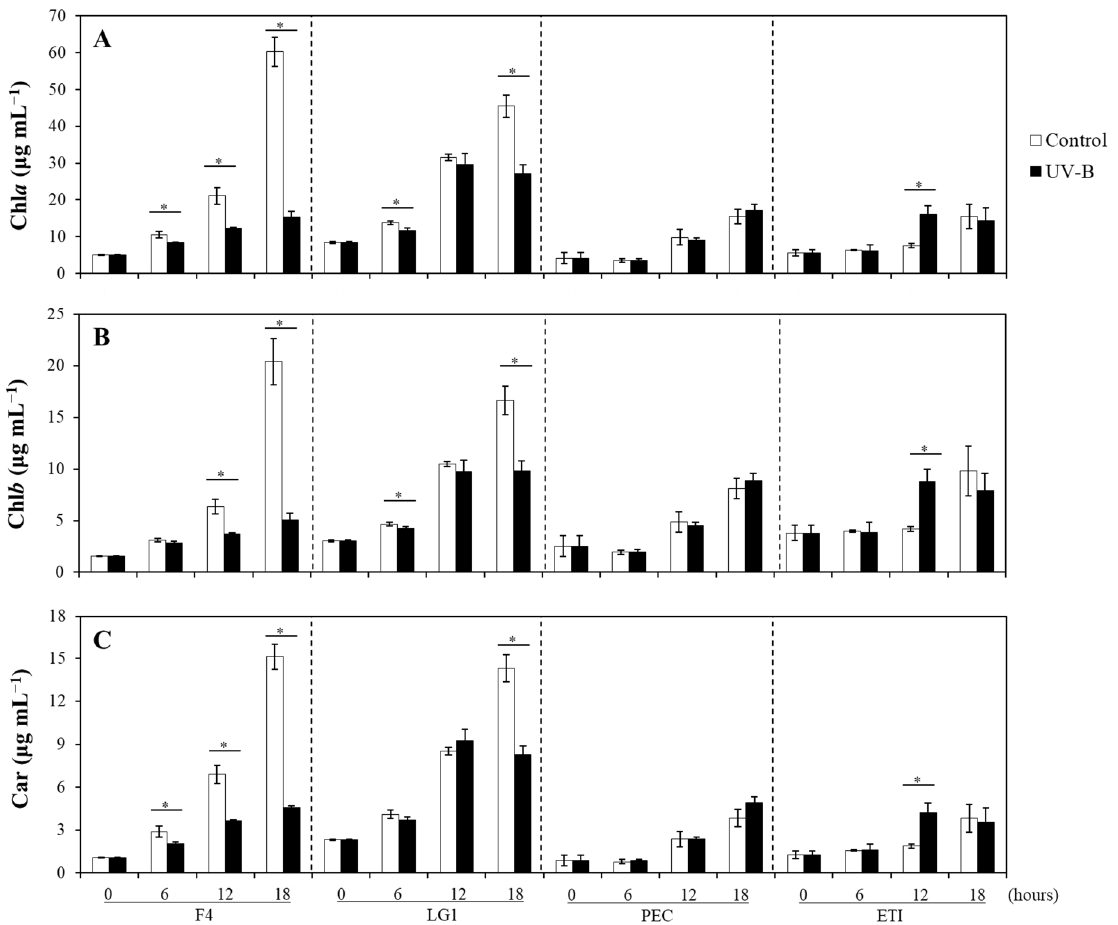
Figure 1. Effects of UV-B on the photosynthetic pigments. ( A ) Chlorophyll a (Chl a ), ( B ) chlorophyll b (Chl b ), and ( C ) carotenoids (Car) concentrations were determined in control (bars in white) and UV-B treated (bars in black) microalgal strains (F4, LG1, PEC, and ETI). UV-B exposure level was set at 1.7 W m − 2 supplemented with 70 μ mol m − 2 s − 1 photosynthetically active radiation (PAR) following a time course from 0 to 18 h. Control microalgal group only received PAR. Asterisks represent significant differences (* p < 0.05) between control and UV-B treatment within the same strain at a specific time point. Data are expressed as means of 3 different replicates ± standard deviation (SD). F4 and LG1: Chlorella sorokiniana strains; PEC: Pectinodesmus pectinatus strain; ETI: Ettlia pseudoalveolaris